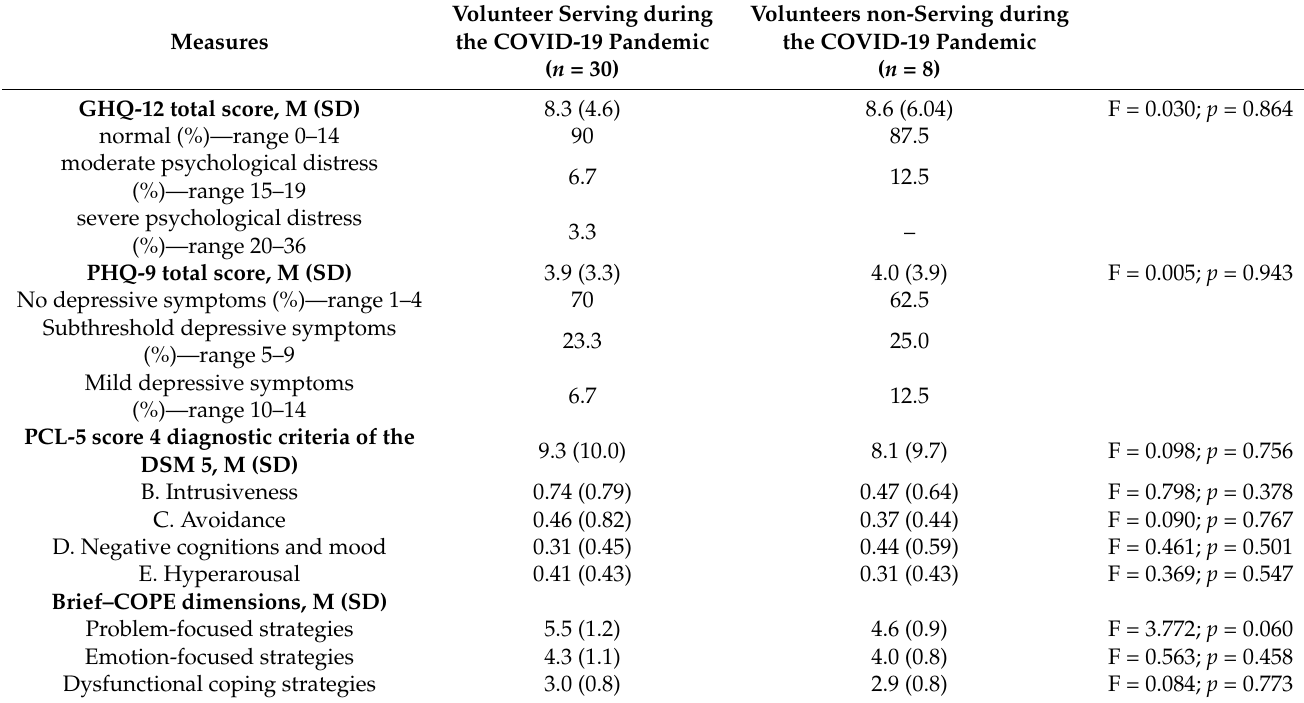
Table 4. Psychopathological and coping strategies data of Civil Protection volunteers serving during the COVID-19 pandemic compared to those non-serving during the COVID-19